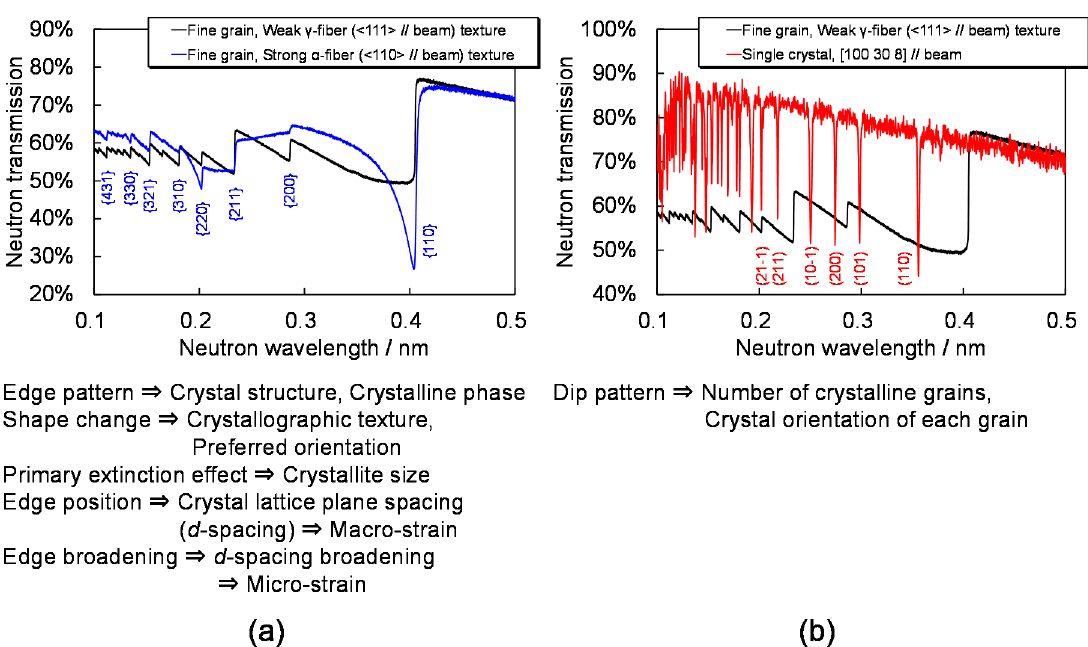
Figure 1. ( a ) Bragg-edge transmission spectrum and the included crystallographic information. The specimen is a polycrystalline α -Fe of 5 mm thickness. ( b ) Bragg-dip transmission spectrum and the included crystallographic information. The specimen is a single-crystal α -Fe of 5 mm thickness. (Note that all the data were measured at J-PARC MLF.) Such transmission spectra are measured at each pixel of a neutron TOF-imaging detector. Therefore, through the transmission spectrum analyses at each pixel, various crystallographic information can be quantitatively mapped over the whole body of a measured specimen.